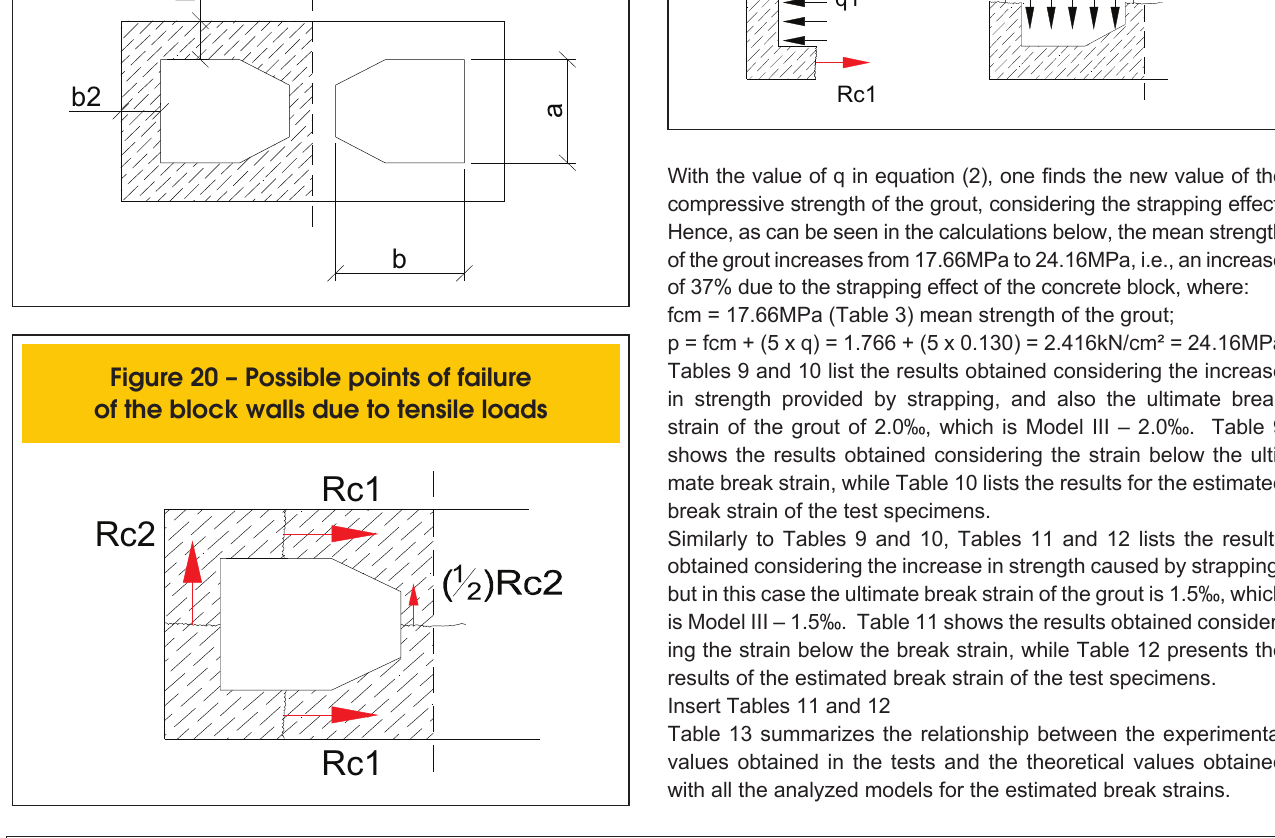
Figure 19 – Plan dimensions of the block; the shaded area is responsible for strapping the grout